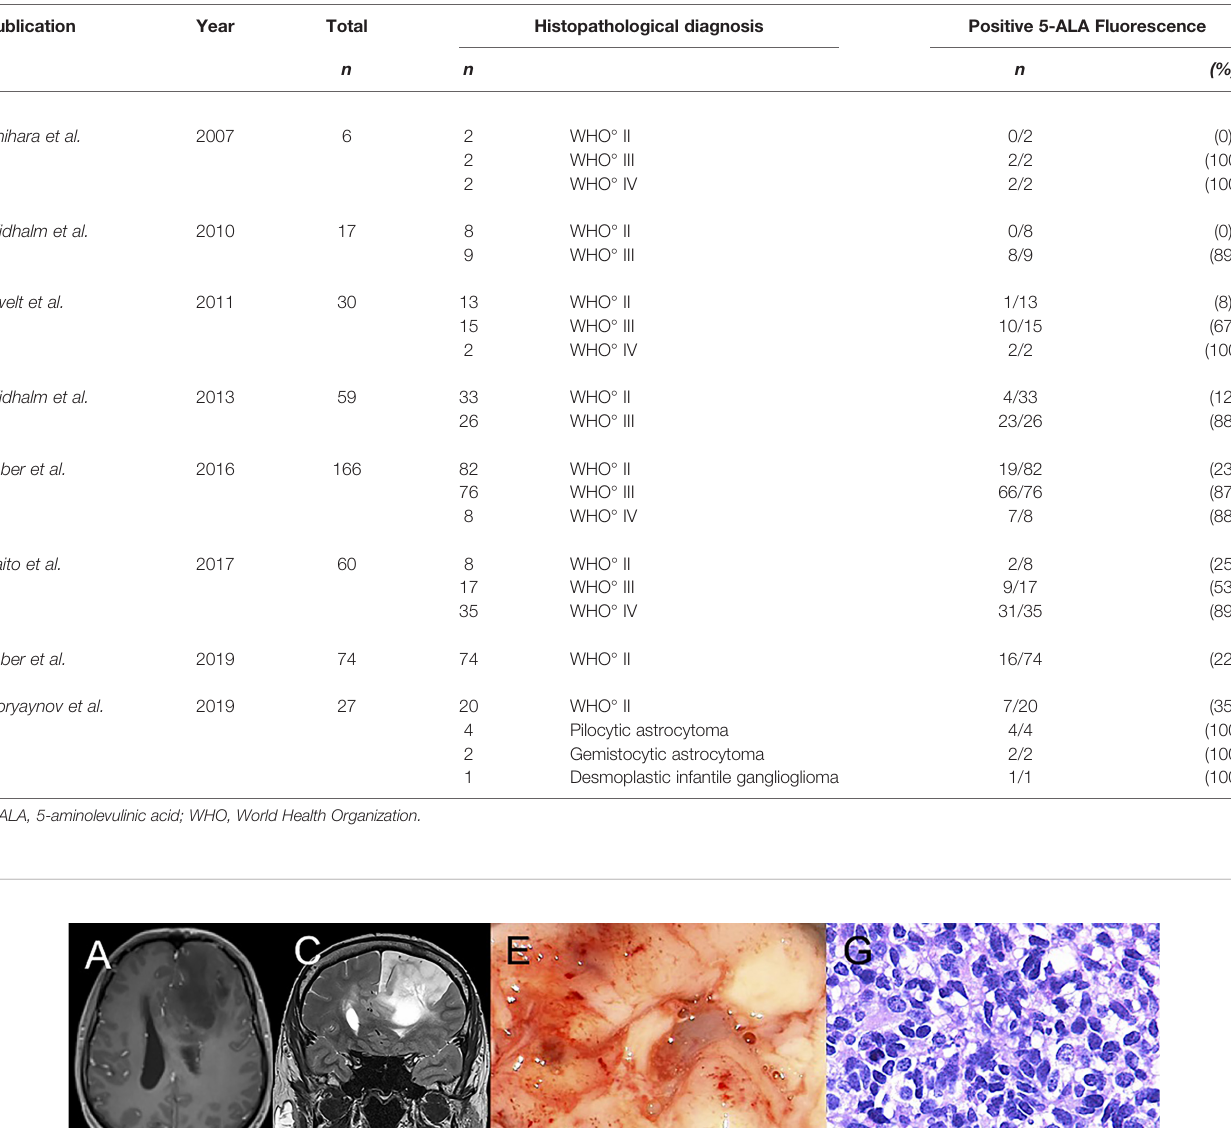
TABLE 1 | Studies in the literature with primary focus on visible 5-ALA fl uorescence including LGG (WHO grade II). Publication Year Total Histopathological diagnosis